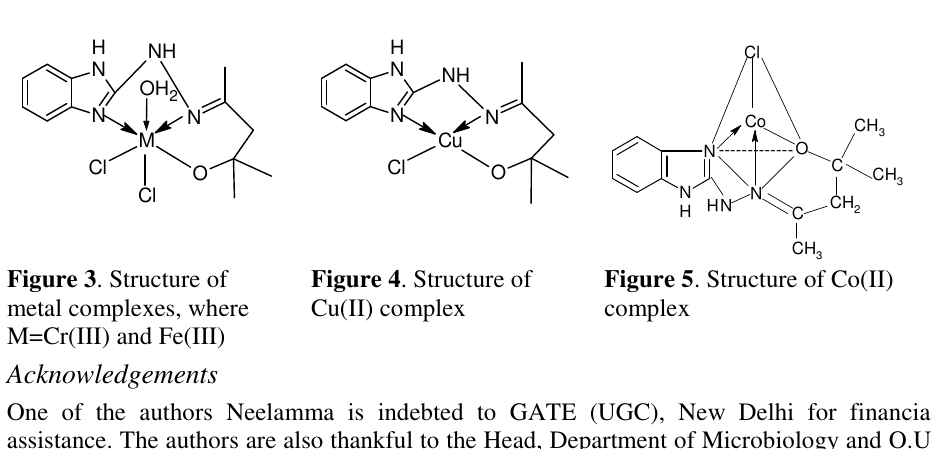
Figure 5 . Structure of Co(II)